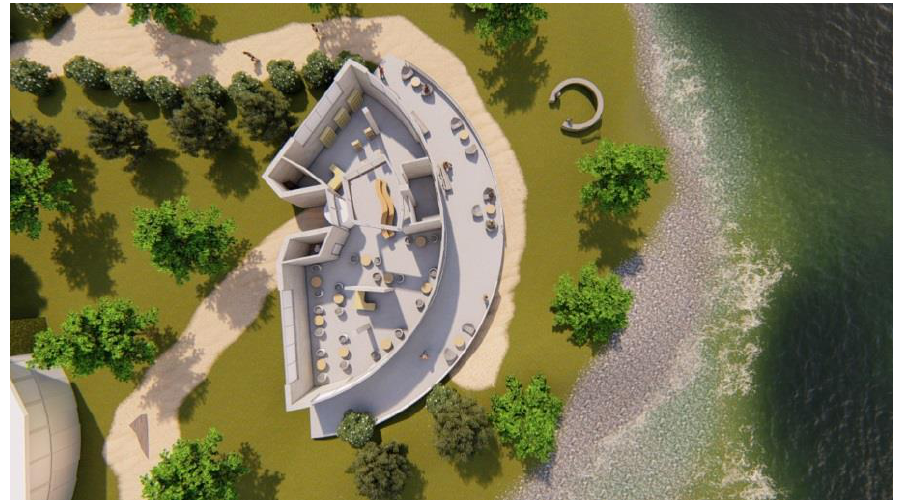
Figure 46. Centre for visitors along the Danube. A very initiative building which fully uses the coastline. Lepenski Vir, Serbia (2019) by ArhiArhi (Predrag, Vladimir and Grigor